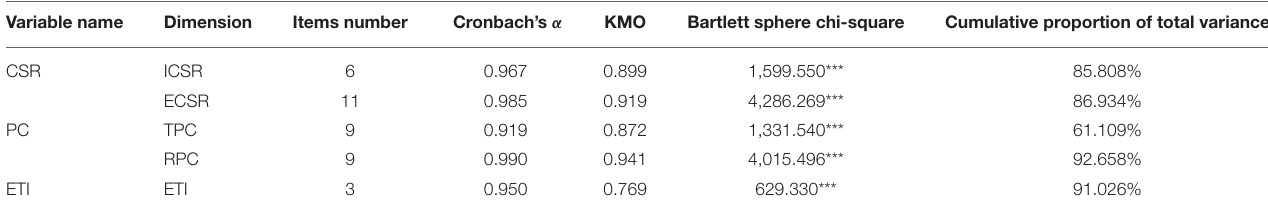
TABLE 1 | Reliability and validity test results of each